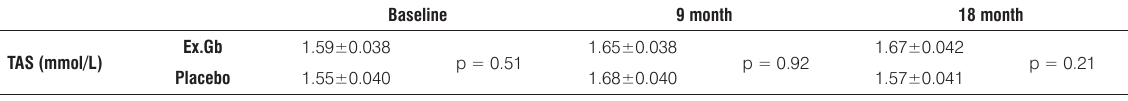
Table 2. Mean of the total conjunctival index and its constituents at baseline, after 9 and 18 months in both groups.